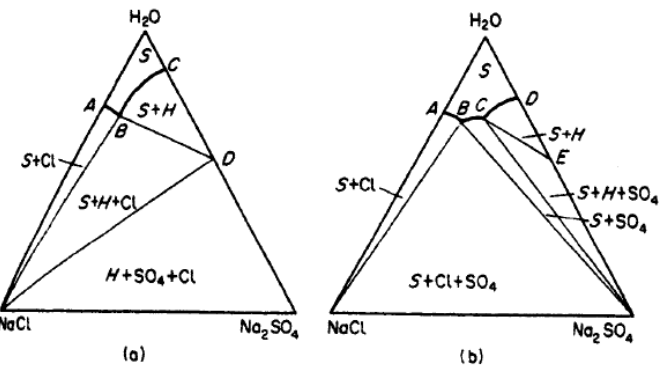
Figure 5. Phase diagrams for the system NACl-Na 2 SO 4 - H 2 O at 17.5 ( a ) and 25 ◦ C ( b ). From Mullin,